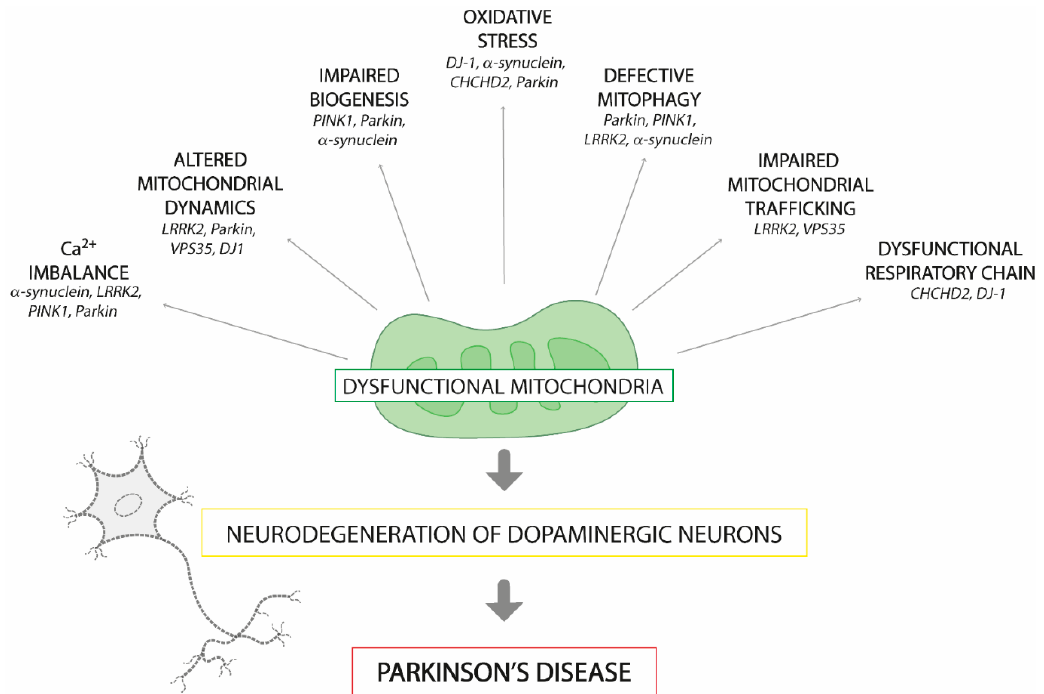
Figure 1. Mitochondrial dysfunctions associated with Parkinson’s disease pathogenesis. The disruption of a gene (in italic) involved in mitochondrial homeostasis may result in the generation of dysfunctional mitochondria in the substantia nigra pars compacta , leading to the loss of pigmented dopaminergic neurons. The consequent dopamine deficit causes the motor symptoms associated with the disease. Abbreviations: PTEN-induced putative kinase 1 ( PINK1 ), α -synuclein ( SNCA ), leucine-rich repeat kinase 2 ( LRRK2 ), vacuolar protein sorting-associated protein 35 ( VPS35 ), coiled-coil-helix-coiled-coil-helix domain containing 2 ( CHCHD2 ).